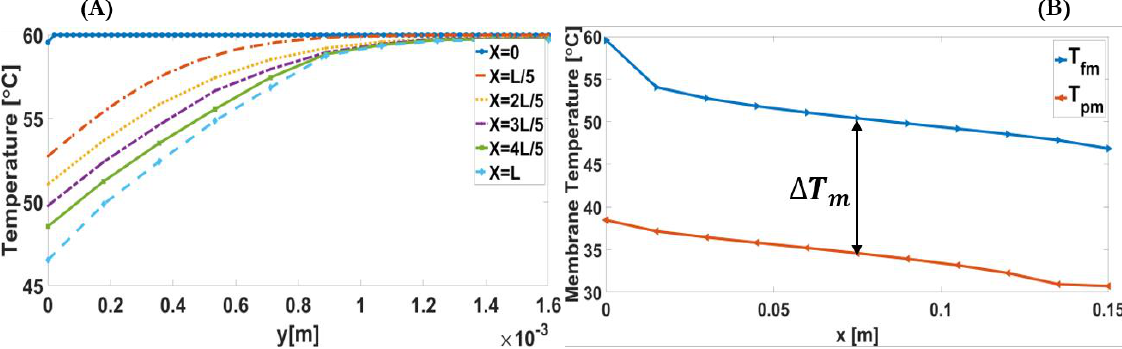
Figure 6. ( A ) Temperature profiles at x = 0, x = L /5, x = 2 L /5, x = 3 L /5, x = 4 L /5, and x = L , illustrating thermal boundary layer in the feed channel. ( B ). Alterations of feed and permeate membrane temperatures, and temperature difference of the baseline condition in counter-current operation of DCMD system.